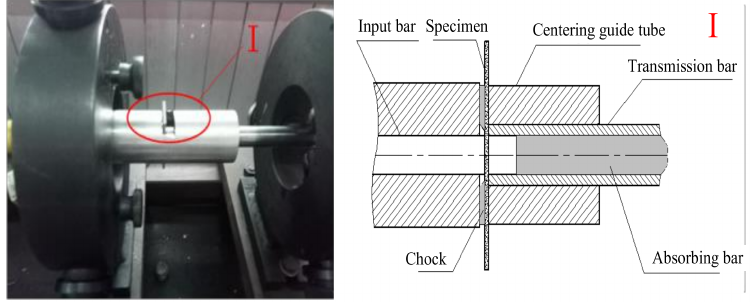
Figure 4. Dynamic Bar-Tube shearing device and enlarge image of I area.